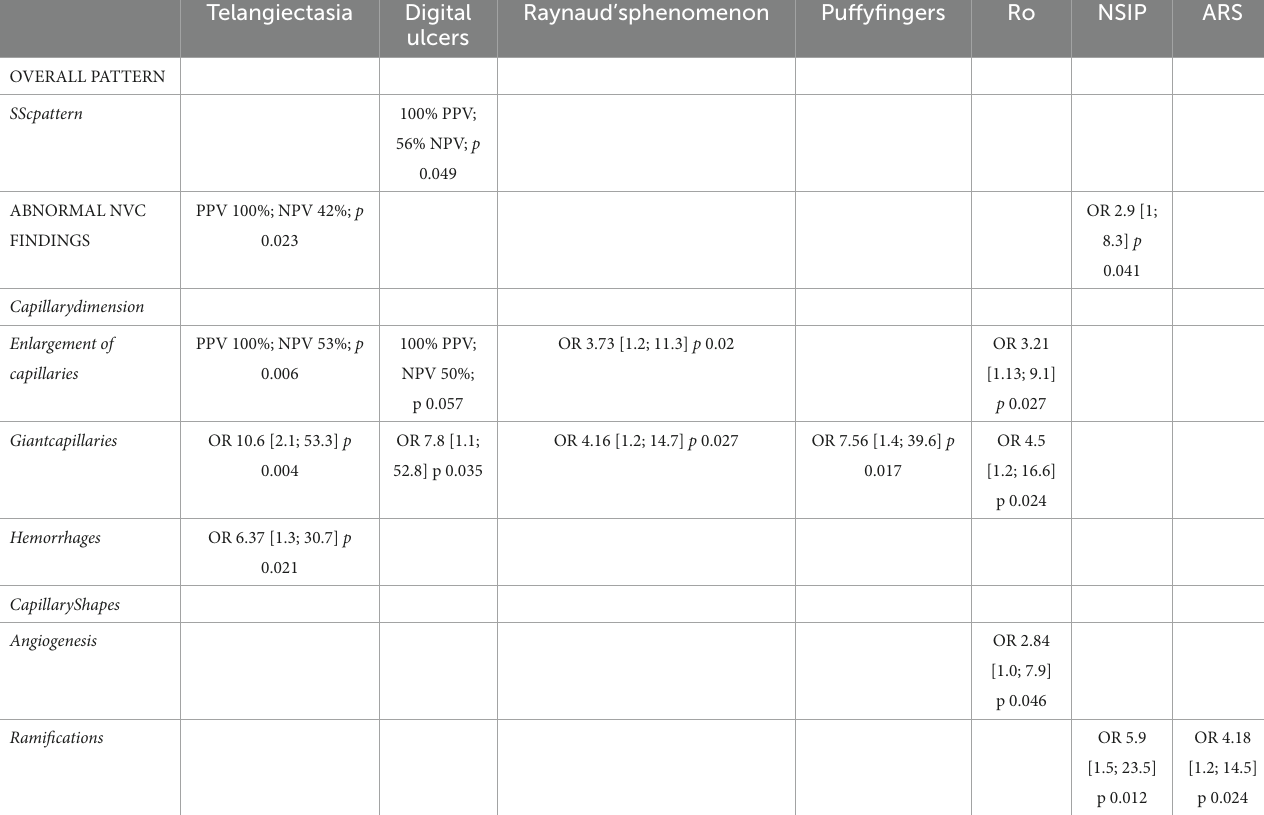
TABLE 3 Predictors of nailfold videocapillaroscopy (NVC) major